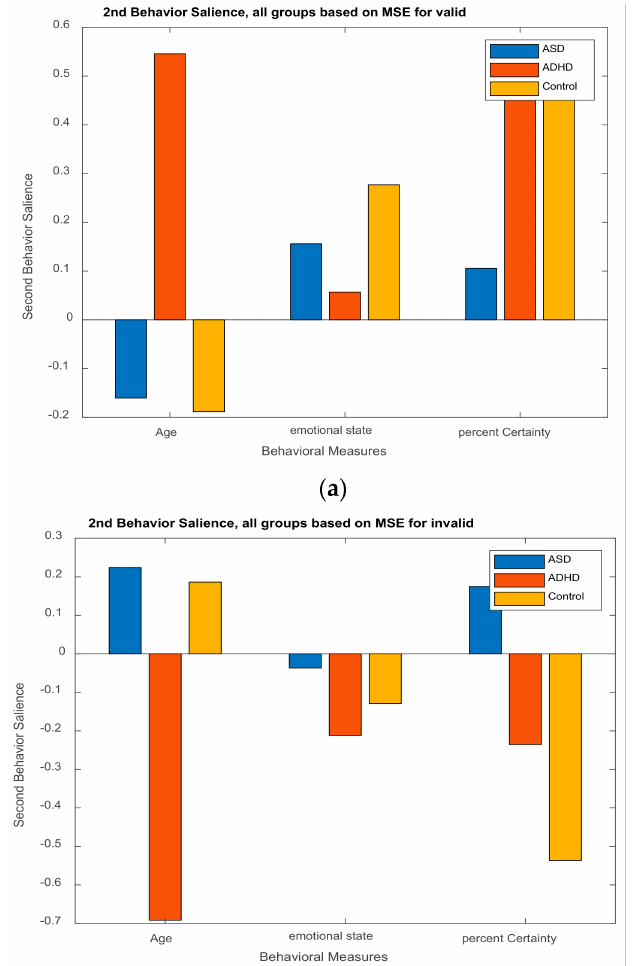
Figure 15. ( a ) 2nd behavior salience, valid syllogism. ( b ) 2nd behavior salience, invalid syllogism. This salience reveals the difference between ADHD (strong negatively correlated) from ASD and control for age, no differences in emotional state, and difference between ASD and other two groups for percent certainty, having also different signs in